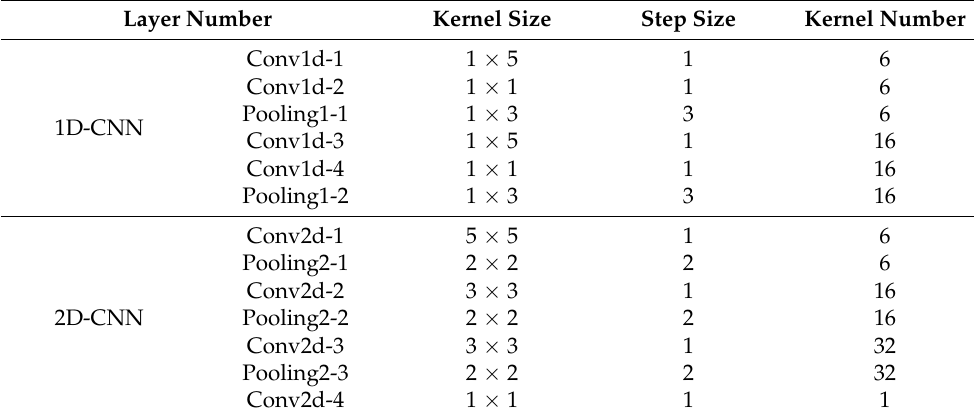
Table 2. The parameters of each layer of the IFCNN